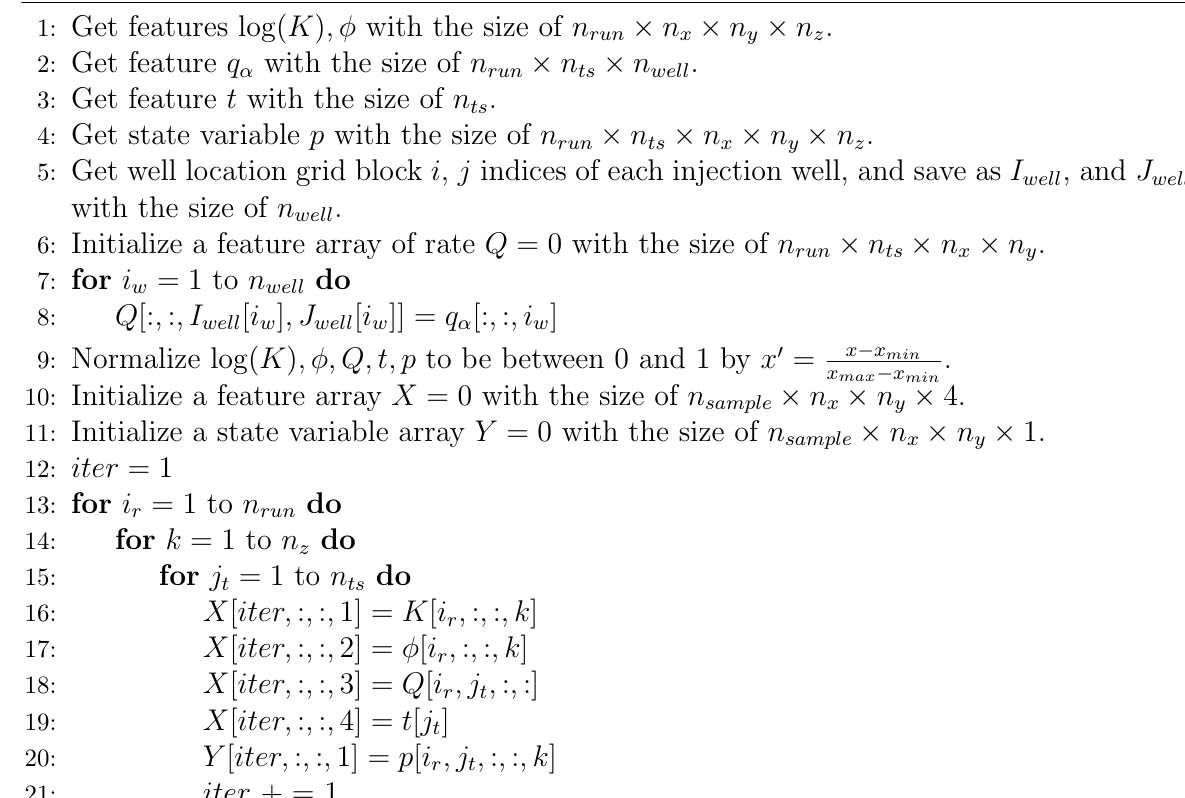
Algorithm 1 : Convert simulation data to the data structure required by DL